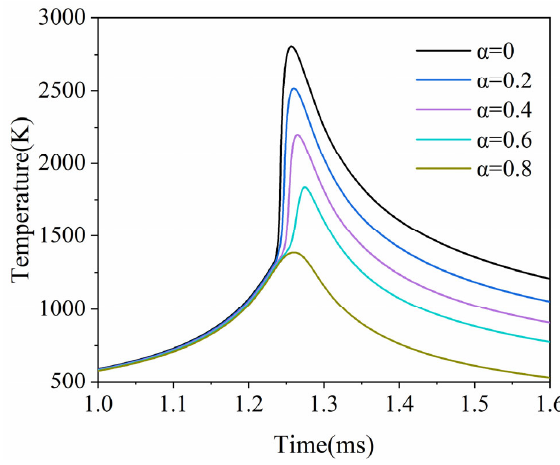
Figure 7. Variation curves of combustion temperature under different α .